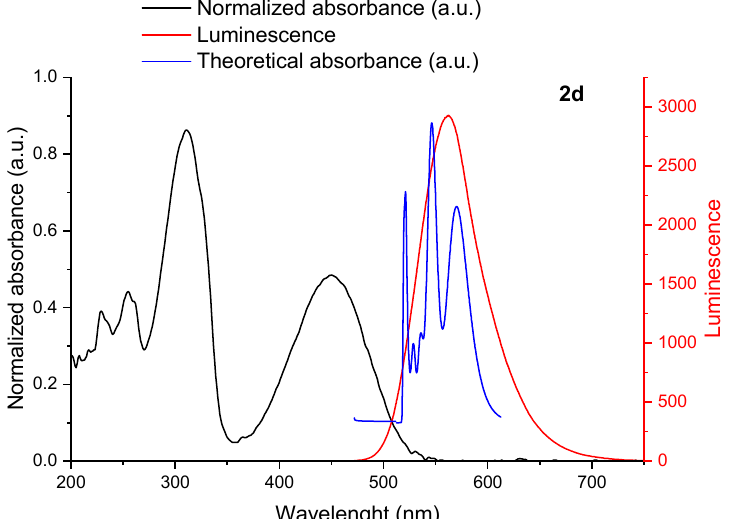
Figure 2. UV-vis experimental absorption (black), theoretical absorption (blue, in vacuum), and emission (red) spectra of compounds 2a – d in dichloromethane (DCM). Table 2. Theoretical properties and maximum of experimental absorption and emission of investi- gated compounds: λ max —maximum wavelength of absorption; λ em max —maximum wavelength of emission; ex —experimental; cal —calculated; f —oscillator